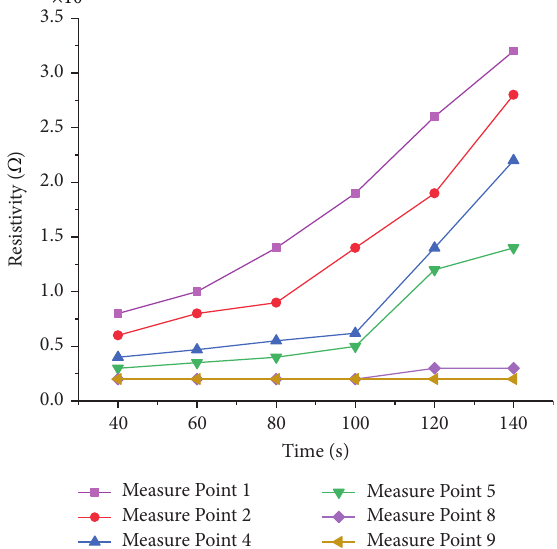
Figure 12: Electrical resistivity distributions along the longitudinal direction.